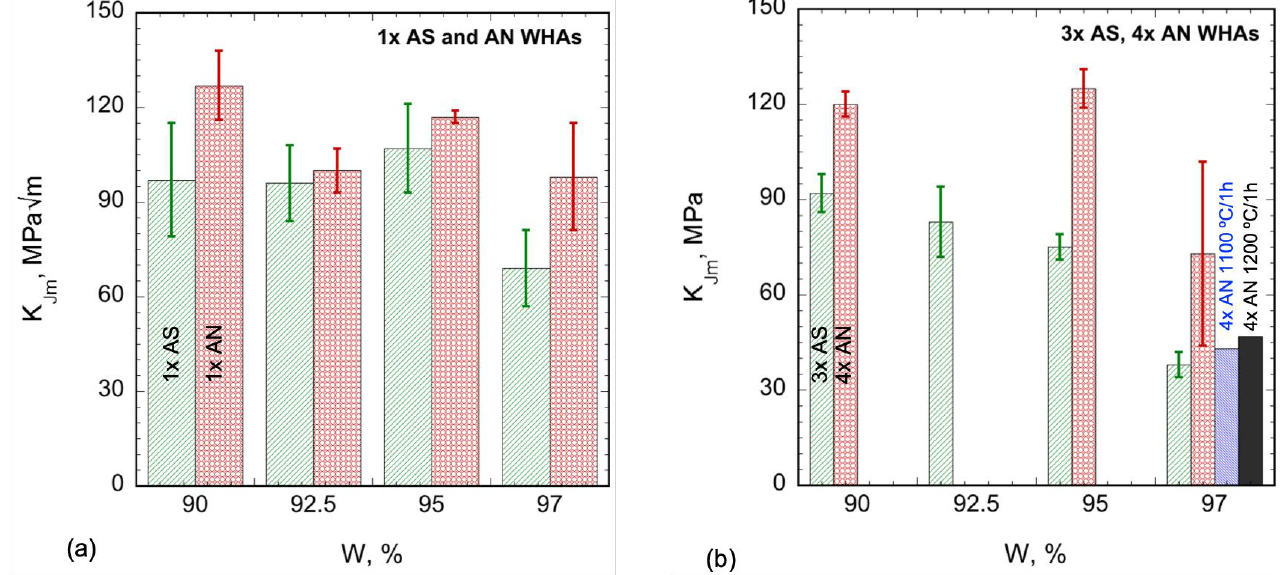
Figure 5. Bar graphs showing the average maximum load toughness K Jm for ( a ) 1× and ( b ) 3− 4× WHA as-sintered (AS) and annealed (AN) specimens. Note, all the specimens were annealed at 1300 °C/24 h, except two of the 4× 97W that were annealed at 1100 and 1200 °C/1 h. Table 4. RT maximum load fracture toughness (K Im and K Jm, in MPa√m) of AS [14,27] and AN WHAs.